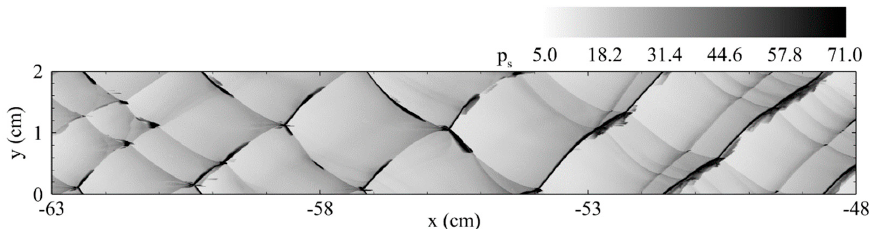
Figure 9. Numerical smoked foil record of the highly unstable detonation cases in H 2 -O 2 mixture.